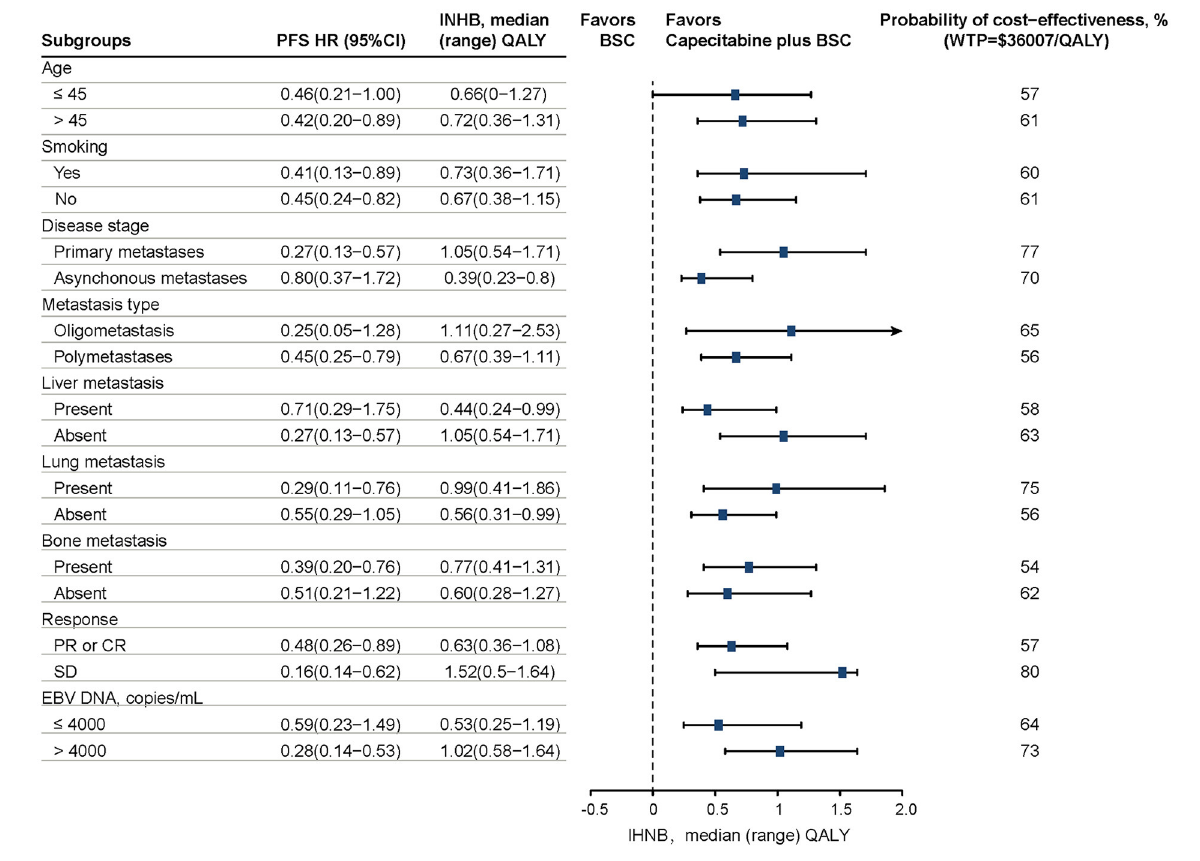
FIGURE2 Results of prespecified subgroup analyses in INHBs and probabilities of cost-effectiveness by varying HRs of PFS. The vertical dashed line indicates the point of no effect (INHB = 0), the blue squares indicate the median INHBs, and the black solid bars indicate the ranges of INHB adjusted by HRs. PFS, progression-free survival; HR, hazard ratio; INHB, incremental net health benefit; BSC, best-supported care; WTP, willingness-to-pay; QALY, quality-adjusted